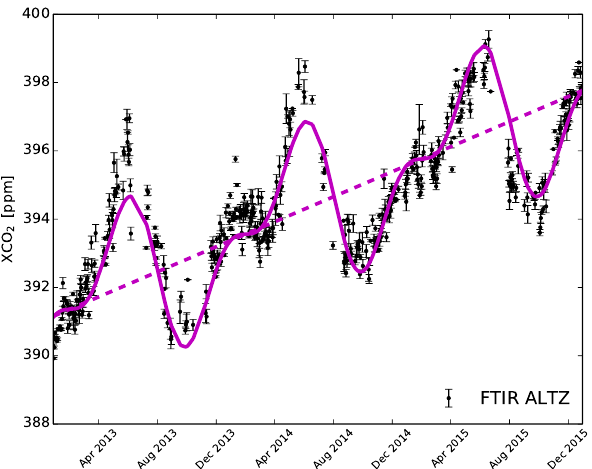
Figure 9. Daily means of the X CO site (black points). The purple solid line is a curve adjusted to the series (see text) with a linear term, represented by the dashed line, of 2.2ppmyr − 1 , which is the trend for this 3-year period.